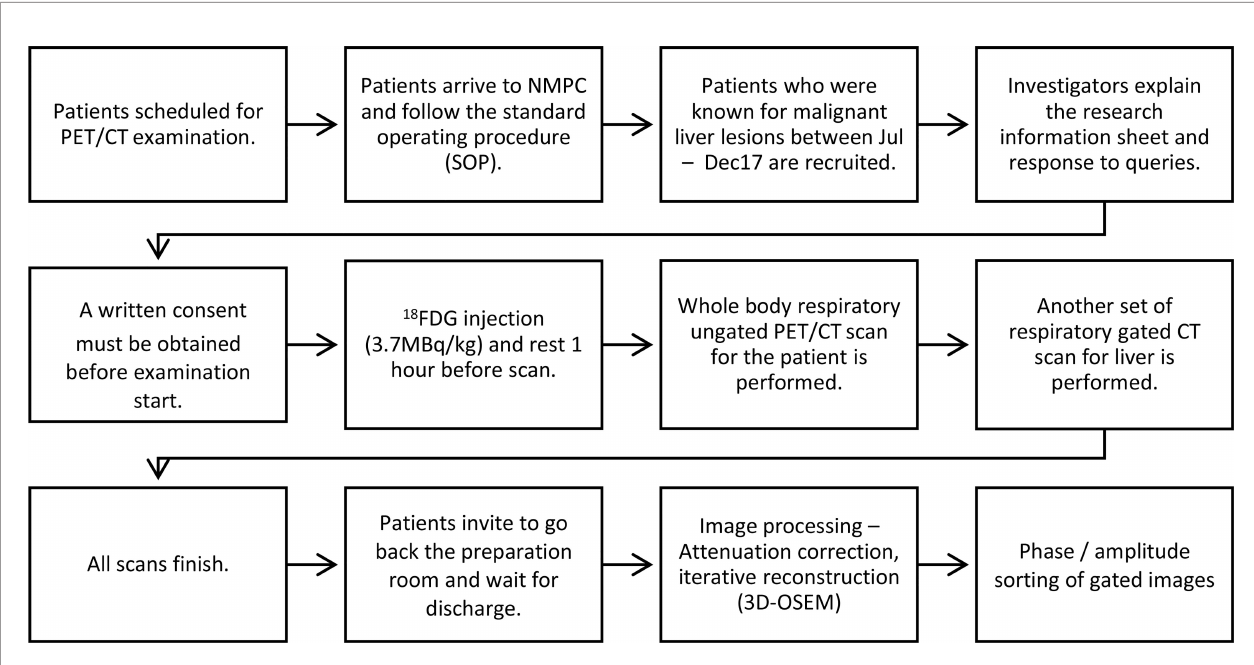
FIGURE 1 | Work fl ow diagram of patients who were included for non-gated PET/CT and respiratory-gated PET/CT